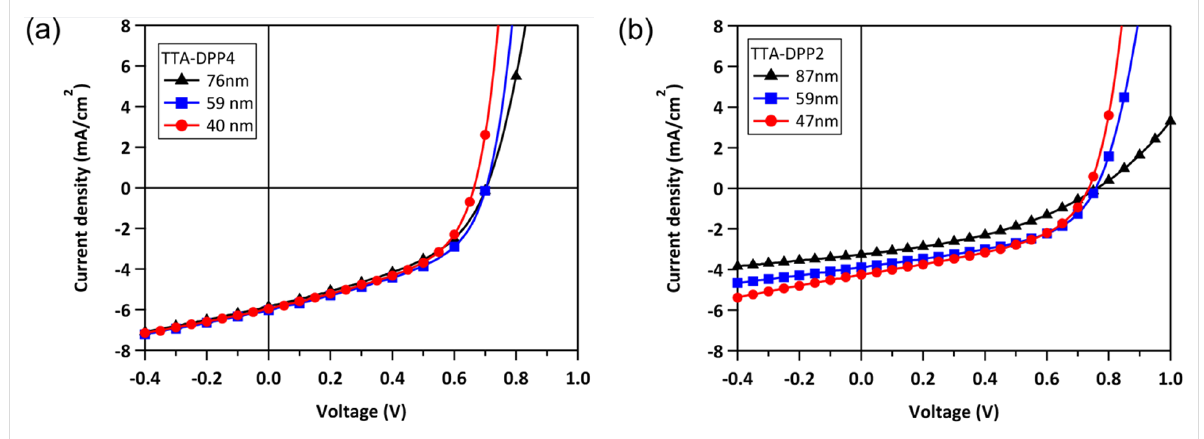
Figure 5: J – V characteristics of BHJ-OSCs based on (a) TTA-DPP4:PC 71 BM (1:1.5, w/w) and (b) TTA-DPP2:PC 71 BM (1:1.5, w/w) with different active layer thicknesses, measured under simulated AM 1.5G, 100 mW cm − 1 illumination.